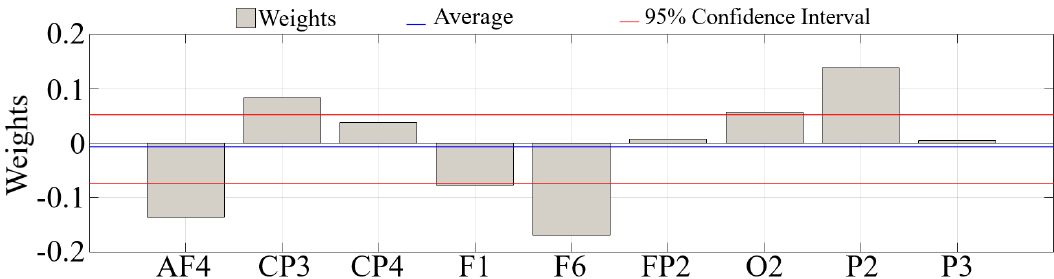
Figure 4. Eyes-Closed (EC) GLM analysis using logistic regression with sigmoid function to determine the importance of each of the significantly different channels between HIGH and LOW stress-susceptible groups for predicting participants’ group membership (i.e., HIGH versus LOW). Channels with significantly different total TEs were FP2, AF4, F1, F6, CP3, CP4, P2, P3, and O2. ANOVA analysis of these weights indicated non-significant difference between contribution of these channels individually and in comparison to other channels’ contribution. Blue line in each subplot marks the average of these coefficients, per setting. Red lines mark the 95.0% confidence interval of these